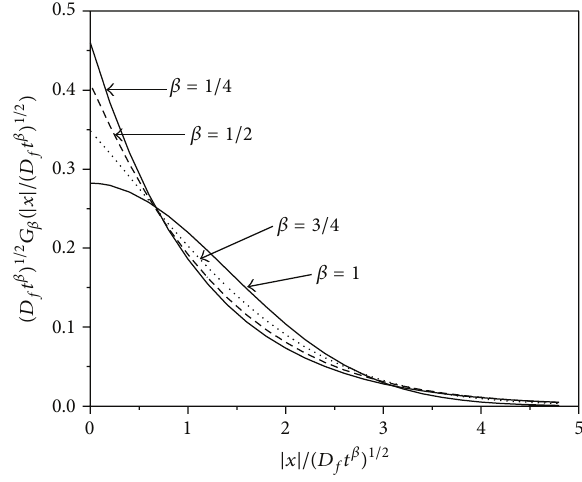
Figure 1: Reduced probability density